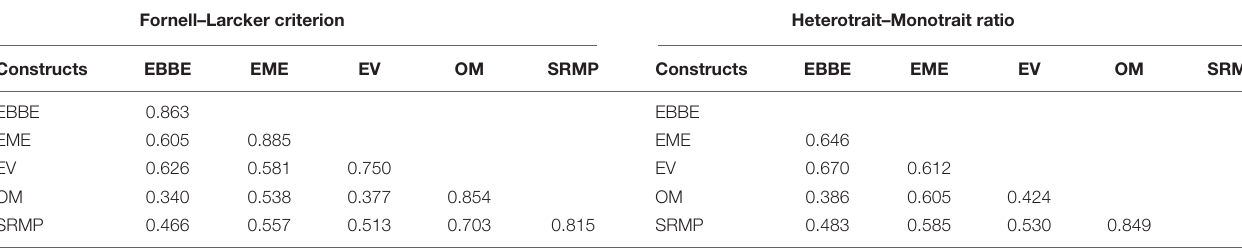
TABLE 3 | Discriminant